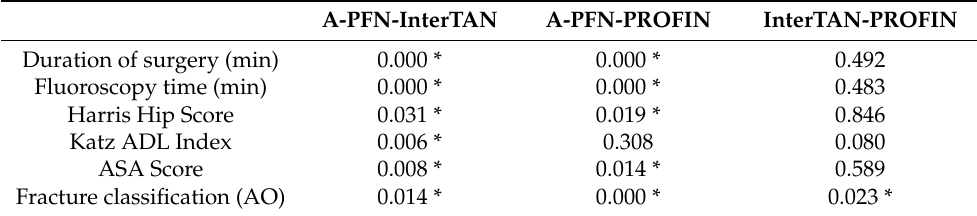
Table 5. Post hoc evaluations of proximal femoral nail